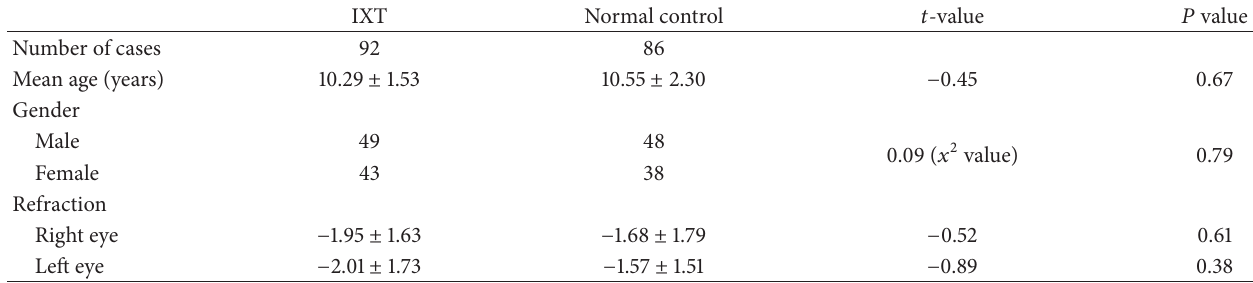
Table 2: Characteristics of patients with intermittent XT and normal